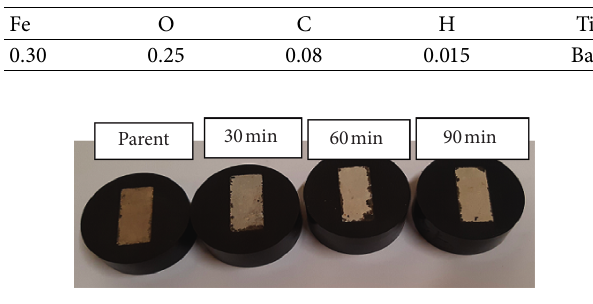
Table 2: Chemical composition of pure titanium grade 2 (wt. %).